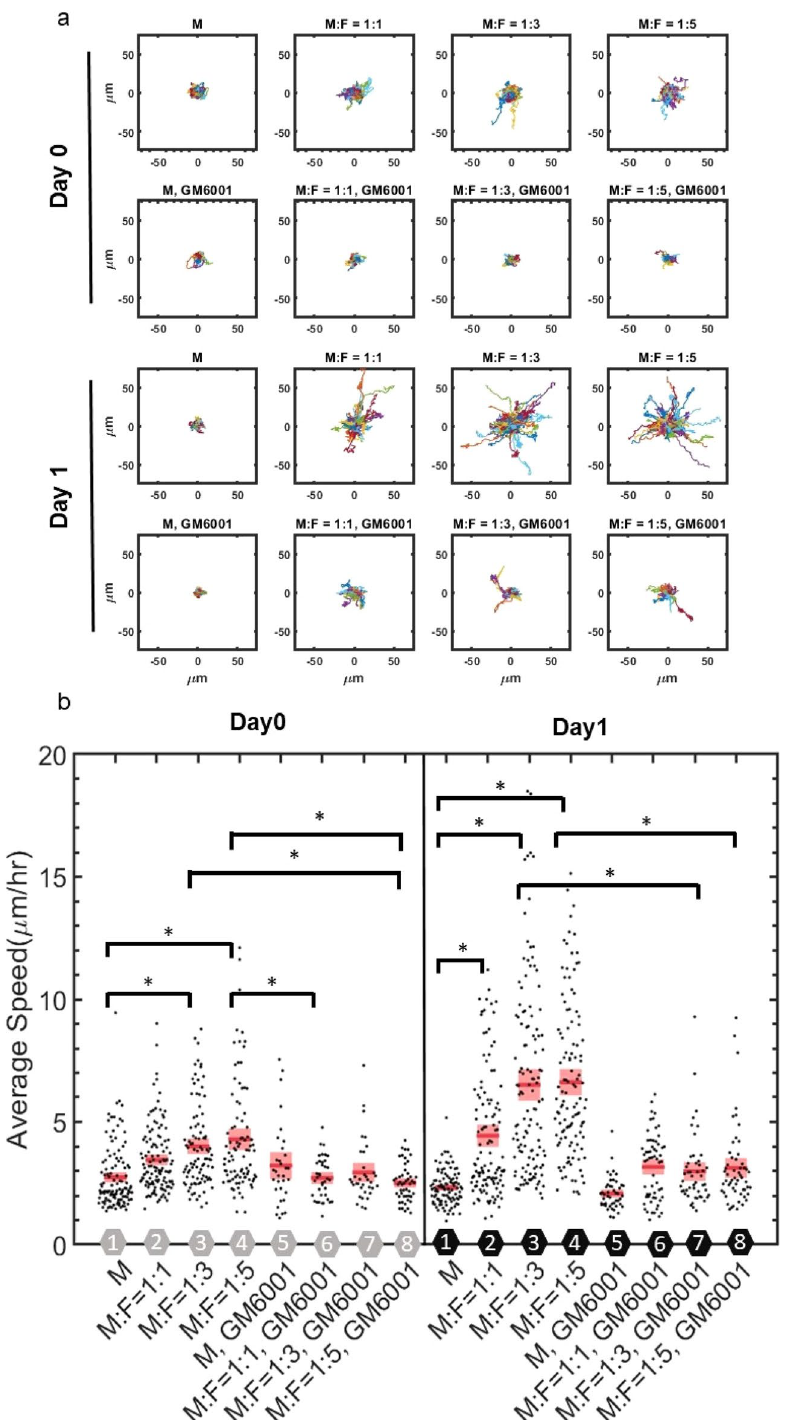
Figure 3. Migration of MDA-MB-231 cells depend on NHLF concentration. ( a ) Overlaid trajectories from each condition truncated at 180 min. M indicates MDA-MB-231, and F indicates NHLF. The ratio indicates the initial seeding concentration ratio of MDA-MB-231 to NHLF cells. GM6001 indicates 20 µm GM6001 treatment. ( b ) Average speed of MDA-MB-231 cells from different conditions. Red line indicates the mean value and pink boxes indicate the 95% confidence interval. Each condition is number coded as indicated by the hexagon along x axis. Gray hexagons indicate day0, black hexagons indicate day1, GM6001 indicates 20 µm GM6001 treatment. In each condition, around 50–120 cells were tracked. Data were collected from at least 3 independent experiments with 2 replicates sampled in each experiment. One way ANOVA was performed to show the difference across all conditions. Tukey’s honest significant difference criterion is used in post-hoc analysis. Histogram data are shown in SI Fig.